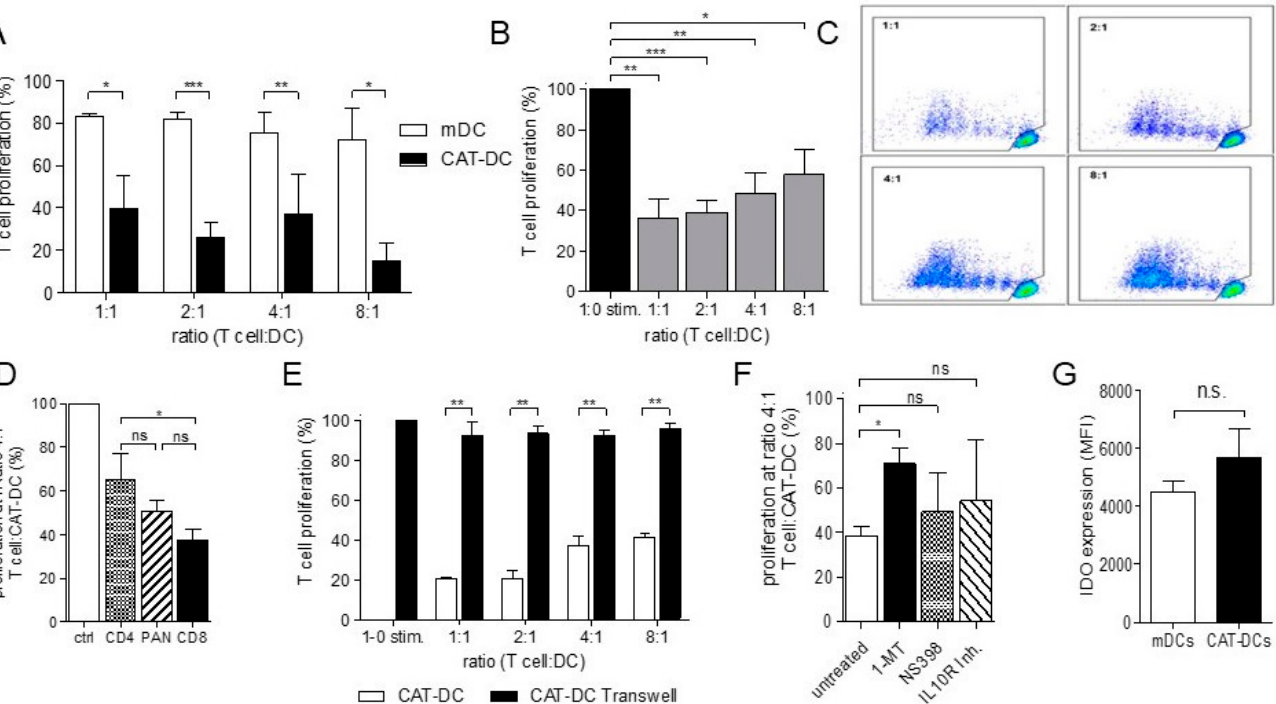
Figure 2. CAT-DCs suppress T-cell proliferation in a contact dependent, IDO-mediated manner. ( A ) Analysis of stimulatory capacity of CAT-DCs on PAN T-cells in comparison to mDCs after 5 days of coculture without addition of CD3/28-beads ( n = 6). ( B ) Proliferation of CD3/CD28-stimulated T-cells cocultured with CAT-DCs for 5 days. Proliferation of T-cells in CAT-DC-cocultures are shown relative to stimulated control ( n = 6). ( C ) Representative flow cytometry plots of T-cell proliferation following CD3/CD28-stimulation after 5 days of CAT-DC coculture. T-cells were stained with Tag-it Violet Proliferation and Cell Tracking Dye to visualize proliferation. ( D ) Comparison of proliferation of CD8 + T-cells, CD4 + T-cells, and CD3 + PAN-T-cells in coculture with CAT-DCs at a ratio of 4:1 T-cell:CAT-DC following CD3/CD28-stimulation ( n = 3, representative plots: Figure S4C; General gating strategy for T-cell-analysis can be found in Figure S5). ( E ) Analysis of CD3/28-bead stimulated T-cell-proliferation applying physical separation (transwell inserts) throughout coculture of T-cells with CAT-DCs in decreasing ratios ( n = 3). ( G ) Analysis of proliferation in cocultures of CD3/28-bead stimulated T-cells with CAT-DCs following introduction of indoleamine 2,3-dioxygenase inhibitor 1-MT, COX-inhibitor, and IL10-R blockade ( F ). Flow-cytometric analysis of intracellular IDO-expression in CAT-DCs as compared to mDCs ( n = 3). Statistical analysis was performed with a paired two-tail Student’s t -test. (* p < 0.05, ** p < 0.01, *** p <